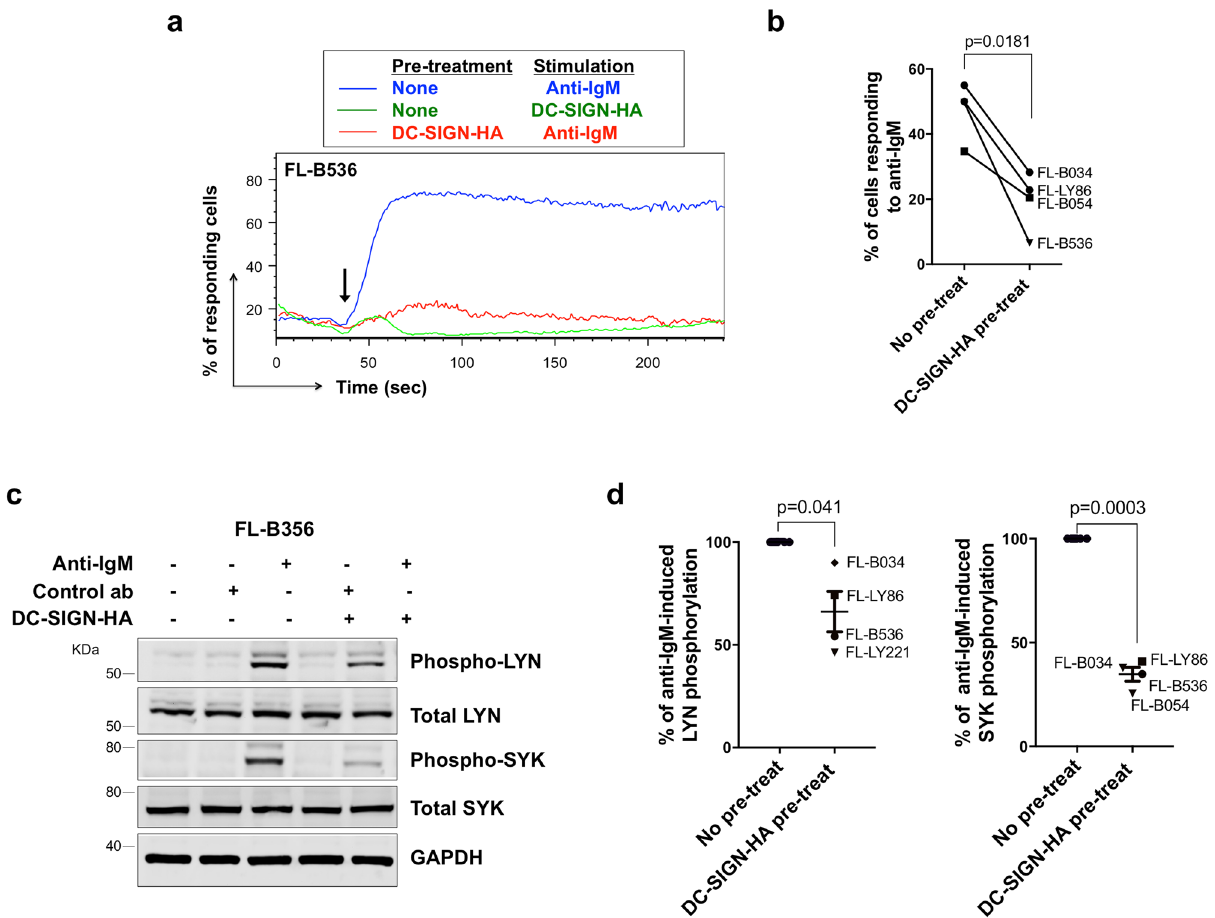
Figure 6. Effect of DC-SIGN on anti-IgM signaling in primary FL samples. ( a , b ) Anti-IgM-induced iCa 2+ flux in primary FL samples following pre-treatment with DC-SIGN-HA. ( a ) Representative results of FL-B536 pre-treated with DC-SIGN-HA follow by addition (arrow) of the stimulation as stated and ( b ) summary of data for 4 samples. Graphs show mean (± SD) response with values for anti-IgM only cells set to 100%. Statistical significance of the indicated differences is shown (paired t-test). ( c , d ) Immunoblot analysis showing effect of pre-treatment with DC-SIGN-HA on total and phosphorylated LYN and SYK expression in anti-IgM-stimulated FL cells. Cells were pre-exposed to DC-SIGN-HA for 30 min at 4 °C and then stimulated for 30 s with control antibody, DC-SIGN-HA or anti-IgM at 37 °C. GAPDH expression was analyzed as loading control. ( c ) Representative results (FL-B536). Gels were run under the same experimental conditions and molecular weight of proteins markers shown as KDa. Full-length blots are shown in Supplementary Fig. 5. ( d ) Summary of data for 4 samples. Graphs show mean (± SD) response with values for no pre-treat (ie anti-IgM treated only) cells set to 100%. The statistical significance of the indicated differences is shown (paired